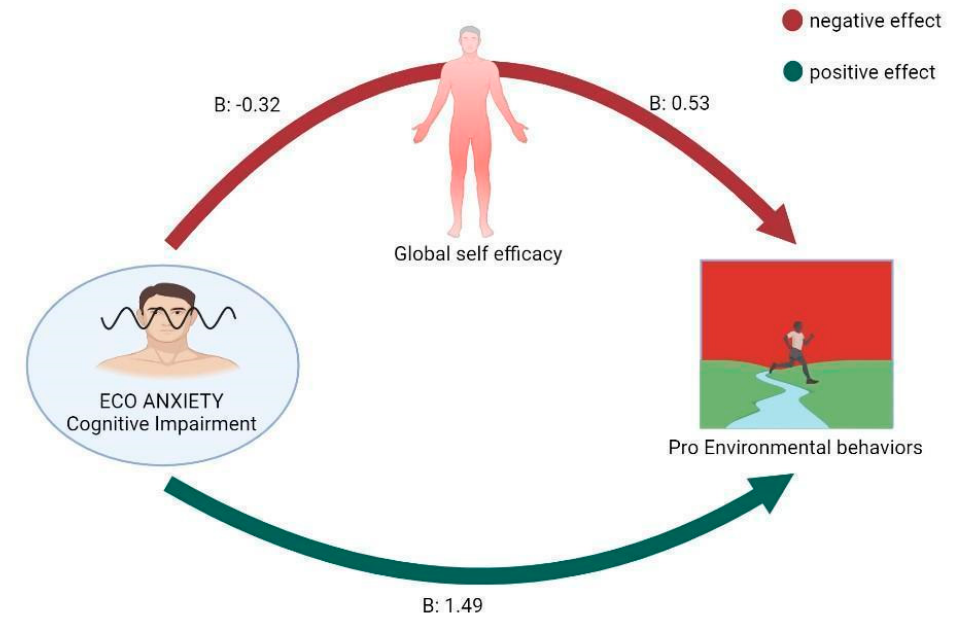
Figure 2. Direct and indirect effect of CCAS on PEBS. (B: regression coefficient).